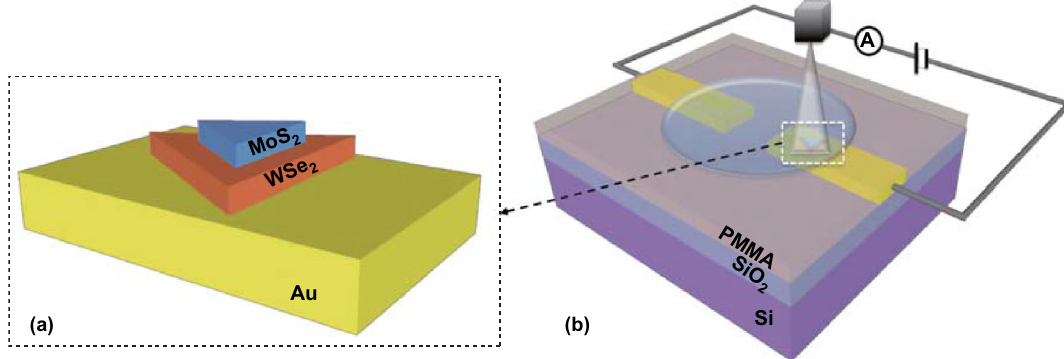
Fig. 1 Schematic of a the MoS 2 /WSe 2 heterojunction and b PEC device and